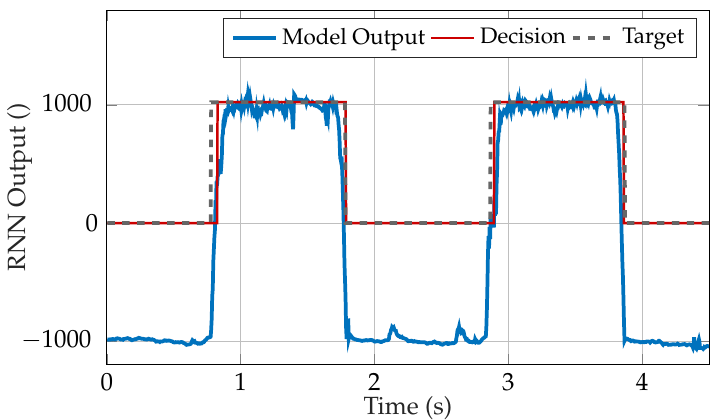
Figure 7. Output, decision and target of the selected RNN for a window of the test data, corrected by the signal delay (Section 2.8.3). The target value is 1024 (= 1 in floating-point format) for contractions and 0 for artifacts. A decision of 1024 leads to an activation of the prosthesis drive. When an artifact is detected, the current output value is maintained or the prosthesis drive is turned off, depending on the selected policy.